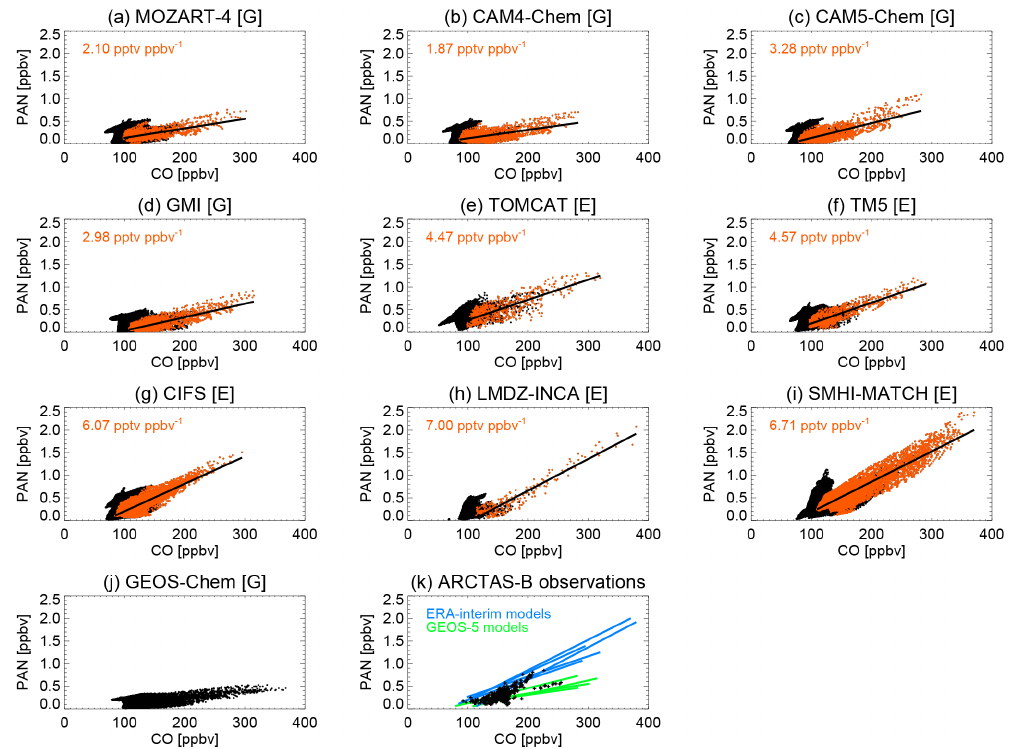
Figure 7. July 2008 PAN / CO relationships for POLMIP models coloured by fire influence. Black: all points north of 50 ◦ N, with 850hPa > pressure > 250hPa. Red points show model grid boxes where the fire fixed-lifetime CO tracer contributes more than 66% of the total (fire + anthropogenic) tracer mixing ratio. Red text gives (cid:49) PAN/ (cid:49) CO slope values for linear regressions of the red points. GEOS- Chem model did not supply fixed-lifetime tracers. Letters in square brackets denote the meteorological analysis data used to drive the models – E: ECMWF; G: GEOS-5. Panel (k) shows ARCTAS-B aircraft observations with slopes from ECMWF (blue) and GEOS-5 (green) models shown for comparison.